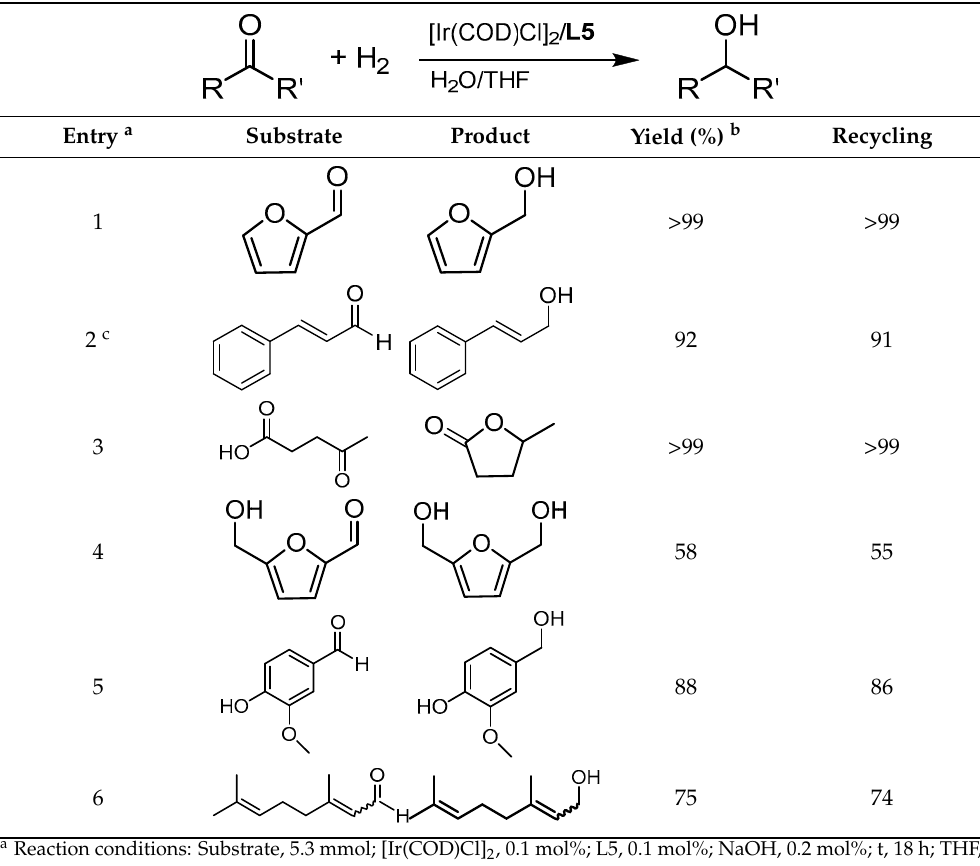
Table 3. Hydrogenation of biomass ‐ derived carbonyl compounds.